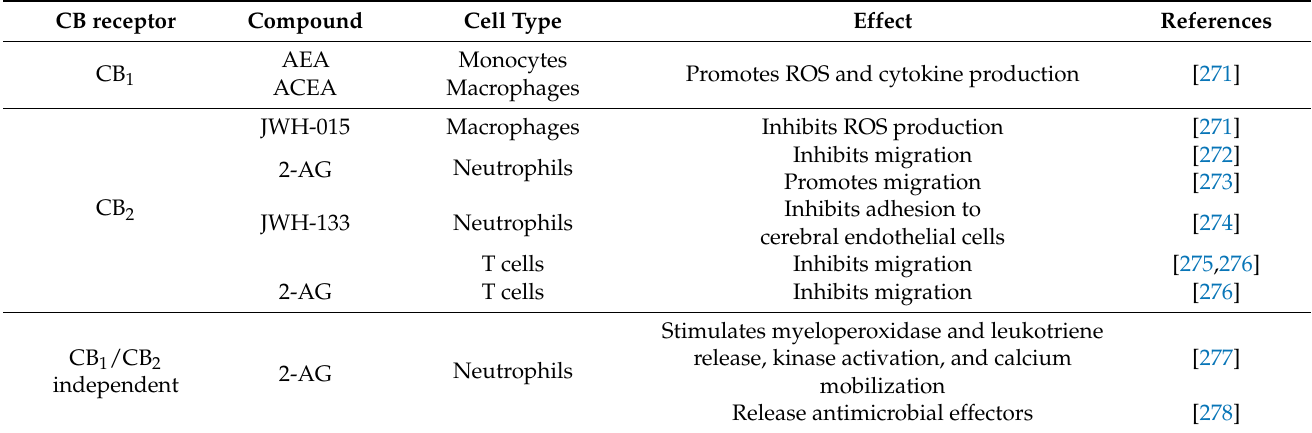
Table 4. Effects of CB 1 /CB 2 receptor activation on leukocyte